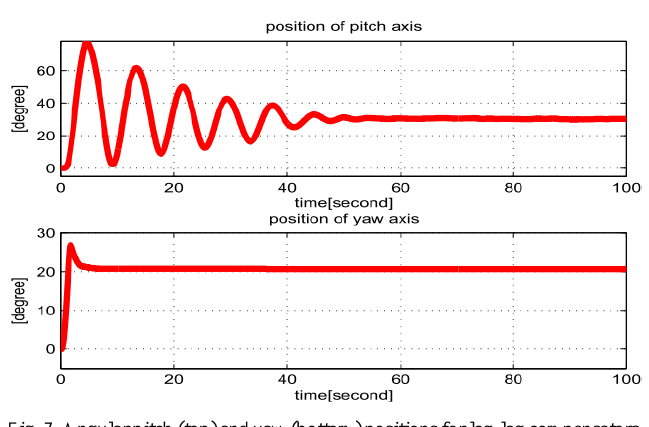
Fig. 7. Angular pitch (top) and yaw (bottom) positions for lag-lag compensators 2 0 . 1 of the form applied on the main and tail 100  motors, respectively.